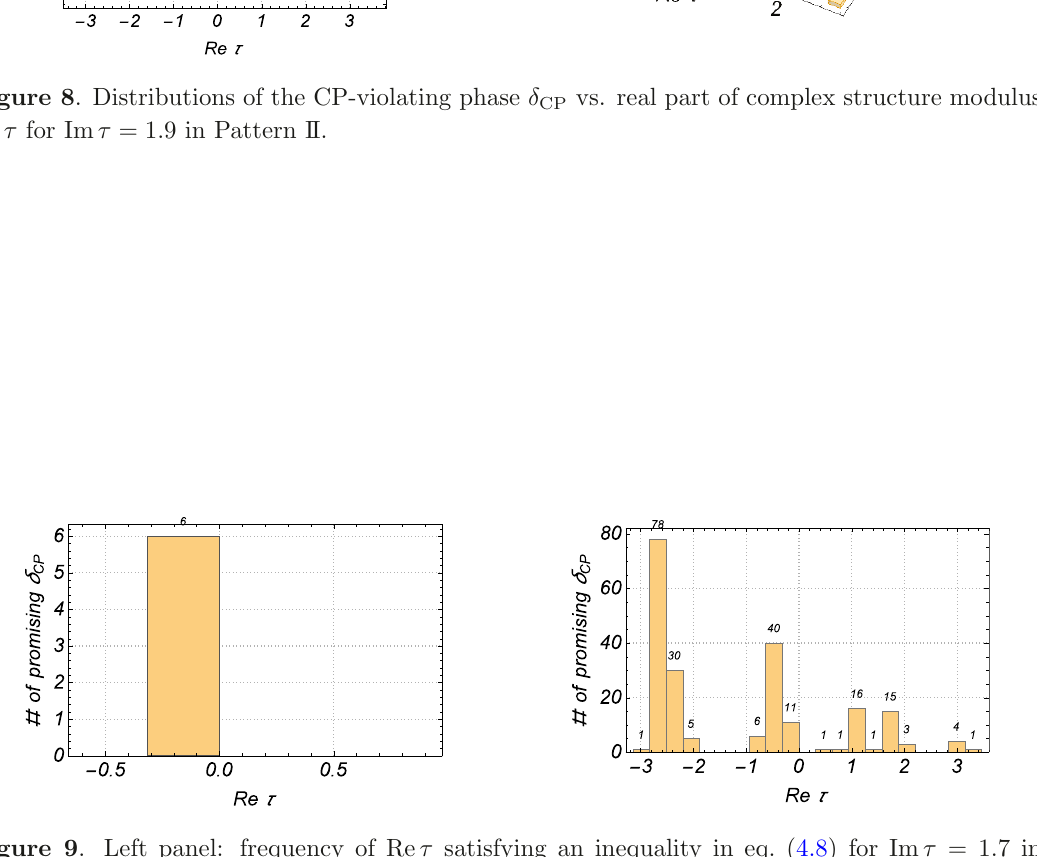
Figure 9 . Left panel: frequency of Re τ satisfying an inequality in eq. (4.8) for Im τ = 1 . 7 in Pattern II. Digits on the top of histogram bins denote the numbers of combinations of Higgs VEVs. Right panel: the same one for Im τ = 1 .